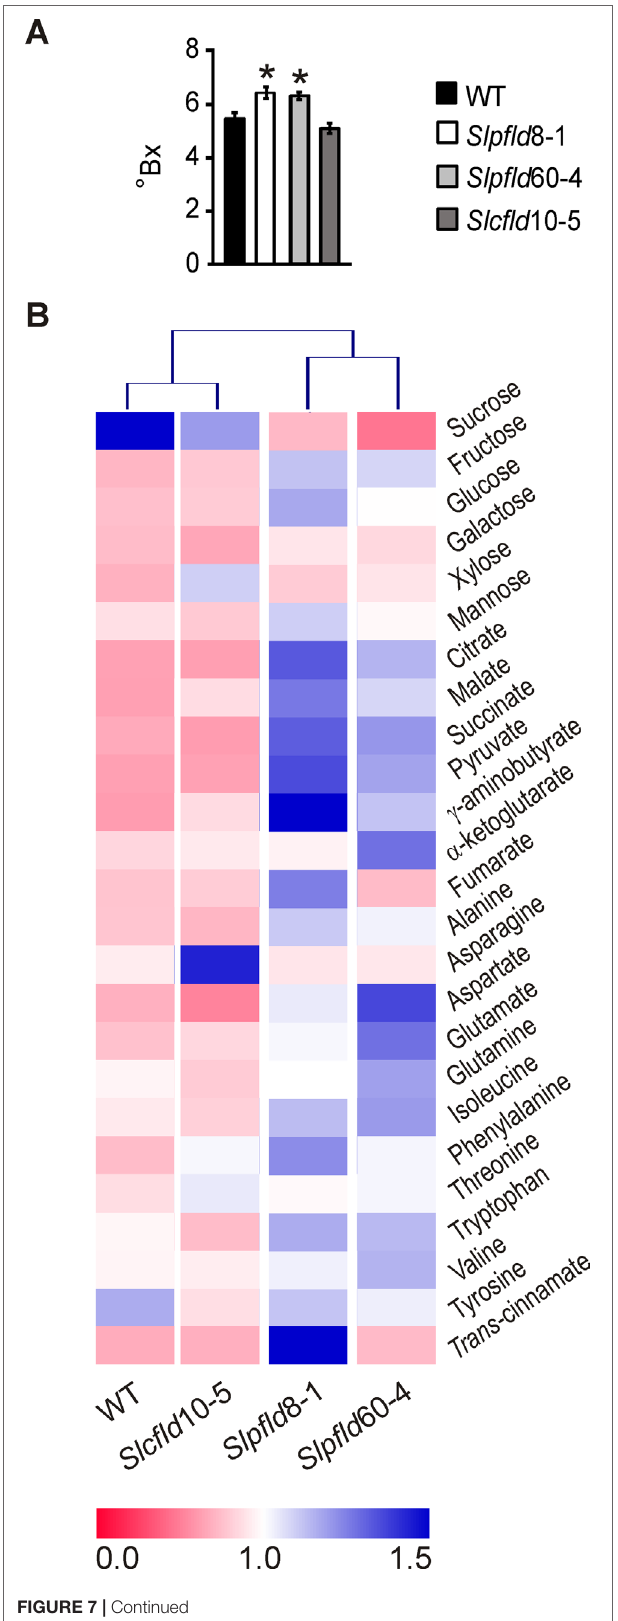
FIgURE 7 | Flavodoxin expression in plastids led to higher soluble solids and metabolite contents in ripe red tomato fruits. (A) Brix Index (°Bx) was determined in at least two fruit from six different plants per genotype (12 fruit per line) using a portable refractometer as described in Materials and Methods . Data reported are means ± SEM. Statistically significant differences are indicated by asterisks and were determined using one-way ANOVA and Tukey's multiple comparison test ( P < 0.05). (B) Heat map of metabolites assayed in the different lines. Values for each compound were normalized with respect to the mean from all lines, and rectangles represent the normalized amount of each metabolite using a false-color scale. Quantitative metabolite profiling was performed in two ripe red fruit of at least three individual plants by 1 H-nuclear magnetic resonance spectroscopy as described in Materials and Methods . Heat map was designed with Multiple experiment Viewer